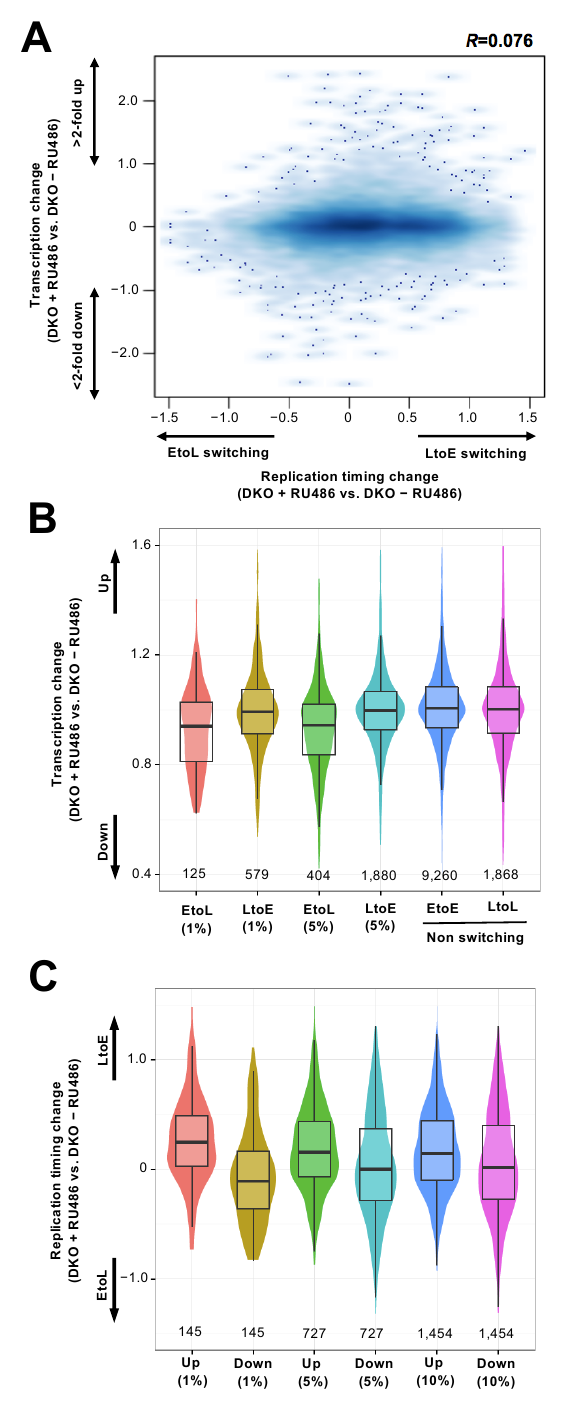
Figure 4. Replication timing changes upon DNA hypomethylation are associated with transcriptional changes. ( A ) Replication timing changes (DKO + RU486 log 2 ratio − DKO − RU486 log 2 ratio) were plotted against the transcriptional changes (log 2 (DKO + RU486/DKO − RU486)). ( B ) Box plots showing the transcriptional changes in EtoL and LtoE switching regions upon Dnmt3a2 induction (segments with an FDR = 1% and 5% from Figure 2C) compared with the non-switching early (EtoE) or late (LtoL) regions. The number of genes analyzed is indicated below each plot. The y -axis is the fold change (not log-transformed). ( C ) Box plots showing the replication timing changes in genomic regions of genes scoring in the top 1%, 5%, and 10% in terms of up- and downregulation. The number of genomic regions analyzed is indicated below each